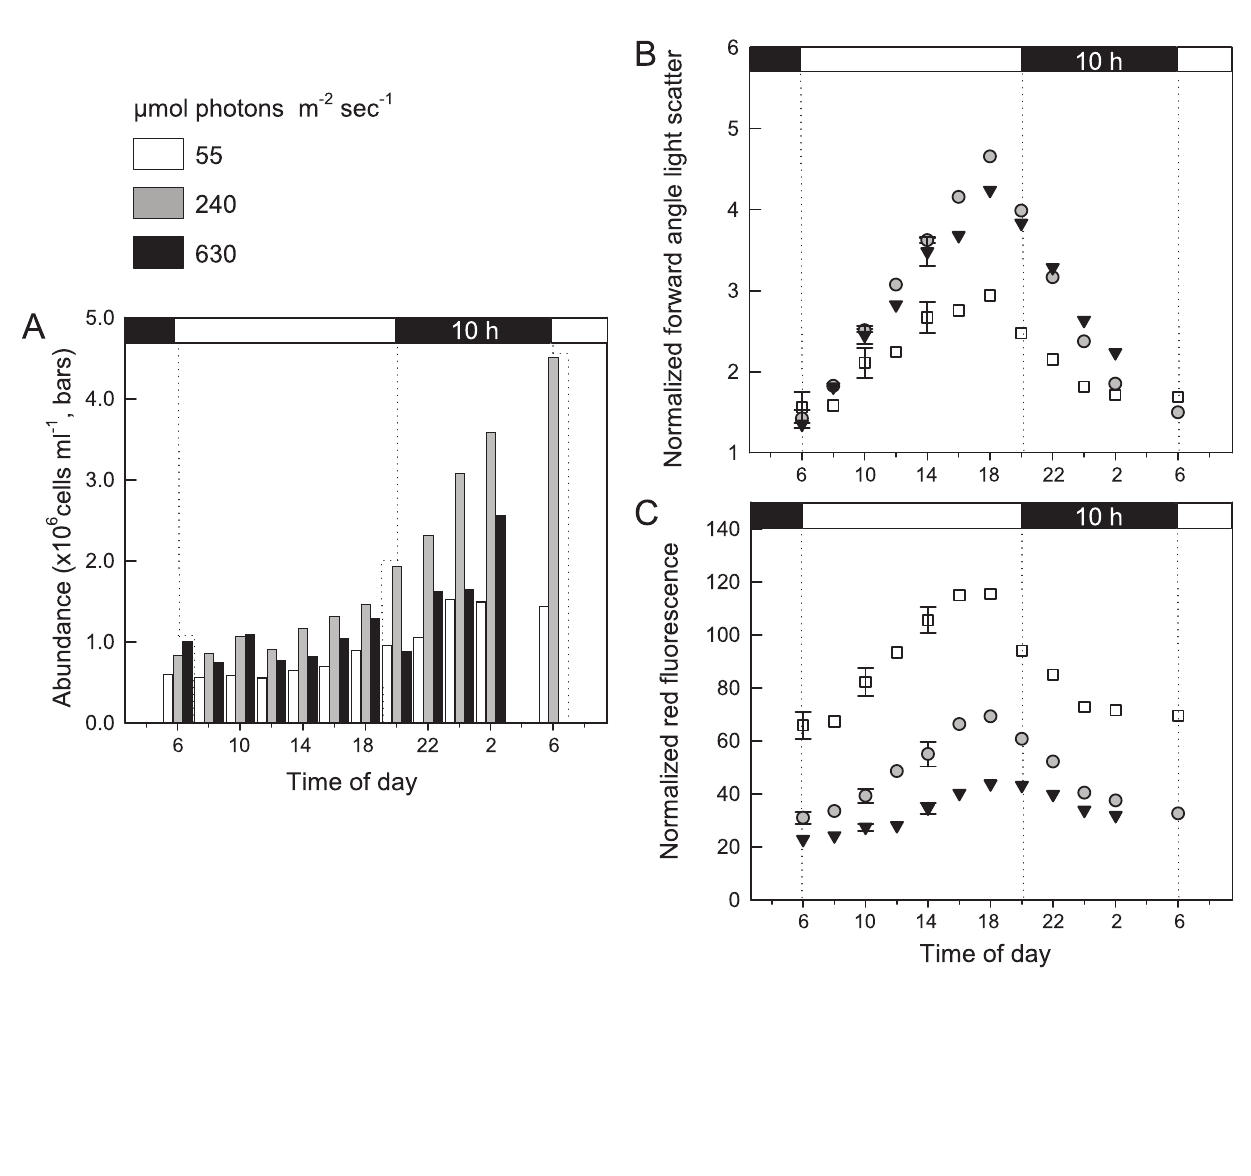
Fig 2. Cellular characteristics over the diel cycle for cultures acclimated to three light levels. (A) Cell abundance, (B) mean FALS in bead relativeunits (i.e., normalized to beads), and (C) mean chlorophyll-derivedred fluorescence in bead relativeunits. The light (white) and dark (black) periods are indicatedin horizontalbars at the top of the graph (14:10 h L:D cycle) and the x-axis is labeled in time of day, with 6 a.m. being lights on. M . commoda growth rates were 1.10 d -1 , 1.76 d -1 and 1.12 d -1 at 55, 240 and 630 μ mol photonsm -2 s -1 , respectively.These growth rates were similar to those of biologicaltriplicatesshown in Fig 1, specifically,1.04 ± 0.04 d -1 , 1.78 ± 0.03 d -1 , and 1.22 ± 0.02 d -1 , respectively, for similar light levels. Values and error bars for the 6, 10 and 14 h time points in (B, C) reflect the mean and standarddeviationof measurements taken duringthe first diel period and those taken every 4 h until 2 p.m. of the followingdiel period. Becausecell numbers increasedwith the passageof time, error was not computed from cell abundances in the first and (partial) second diel periods. Note that the HL sample for 6 a.m. on day two was lost due to instrument